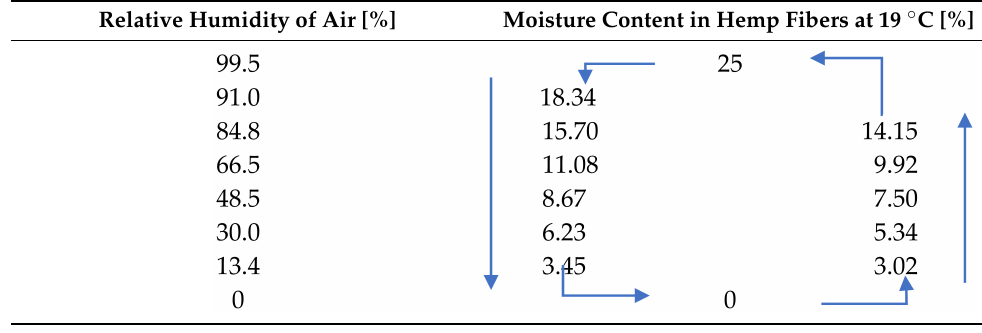
Table 5. Moisture hysteresis of hemp fibres.